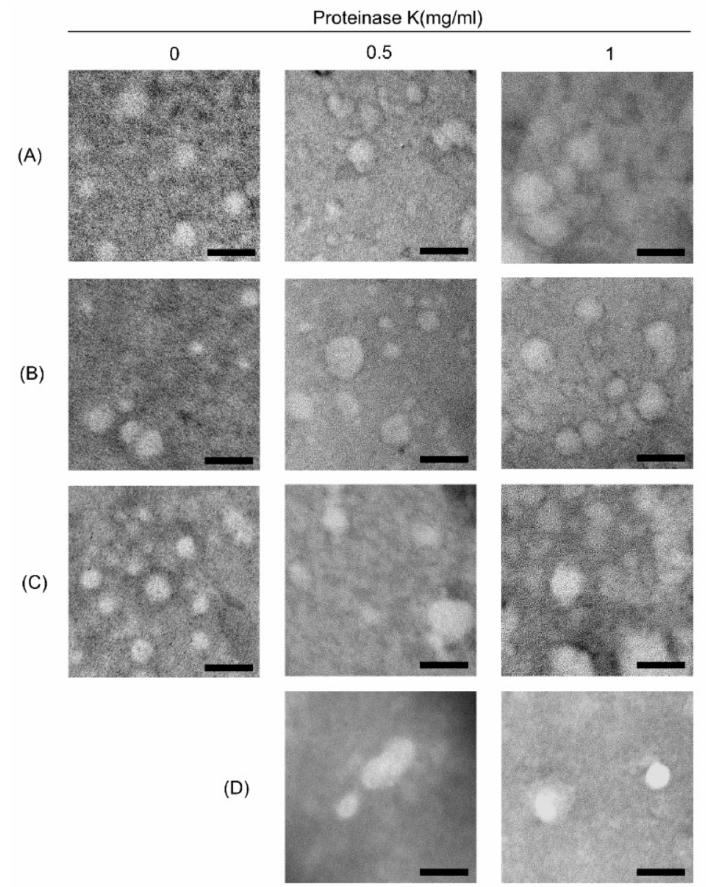
Figure 3. Electron microscopic image of exosomes following di ff erent isolation method. ELVs were purified using ( A ) SBI, ( B ) LT, ( C , D ) QIAGEN treated with di ff erent concentration of proteinase K